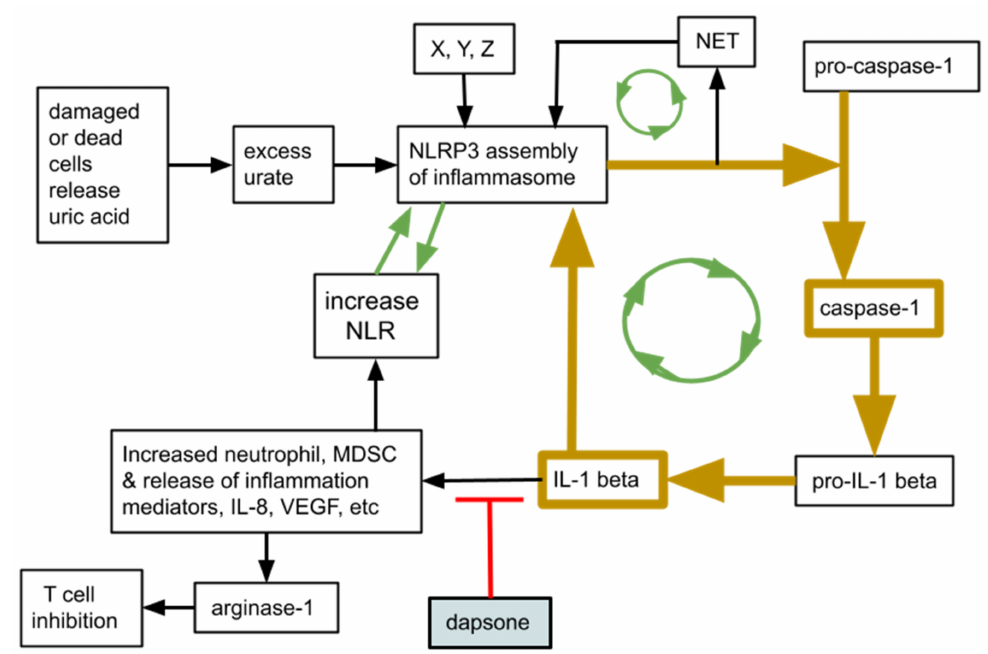
Figure 1. Simplified schematic of the relationship between the neutrophil-to-lymphocyte ratio (NLR), the NLRP3 inflammasome, neutrophil extracellular traps (NET), and IL-1beta. Note the green arrows indicating possible amplifying feedback loops that are one of the elements in “cytokine storm”. There are many other entry points and signaling systems not shown that trigger these elements and many de-amplifying, suppressing elements interacting with this system that are not